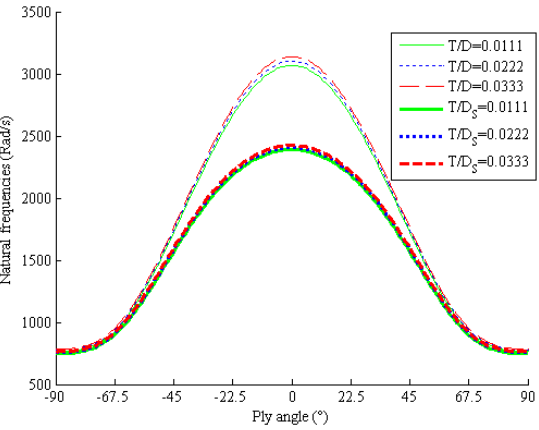
Figure 5. Natural frequencies of the two models for different T/D ratios.